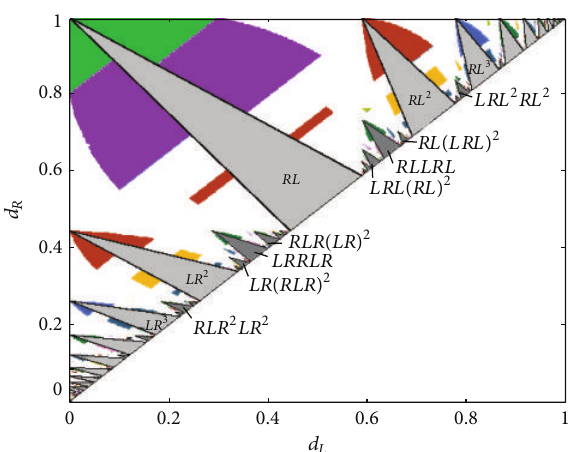
Figure 8: Periodicity regions of the cycles 𝐿𝑅 𝑛 and 𝑅𝐿 𝑛 , 𝑛 = 1,...,11 , of complexity level one are shown in light gray. A few periodicity regions of complexity level two are shown in dark gray. Here 𝑎 𝐿 = 0.7 , 𝑎 𝑅 = 0.8 as in Figure